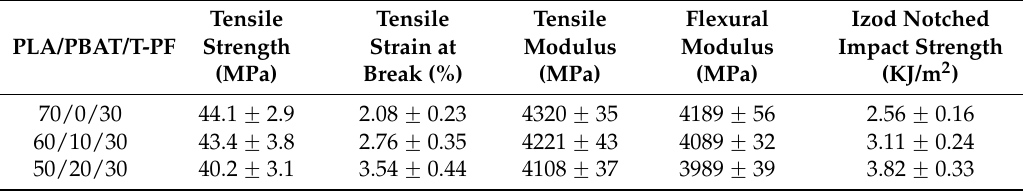
Table 1. Mechanical properties of PLA/PBAT/T-PF composites.